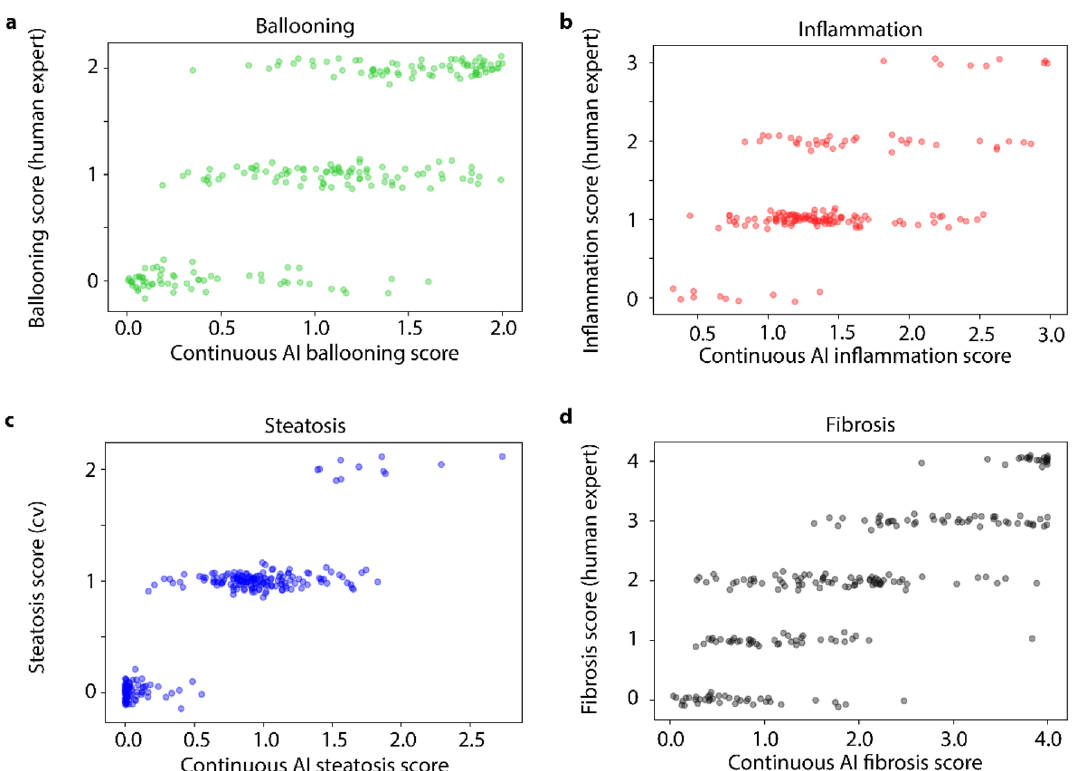
Figure 6. Continuous AI scores vs. discrete ground truth scores. Results for ( a ) Ballooning, ( b ) inflammation, ( c ) steatosis, and ( d ) fibrosis. AI scores on the horizontal axis are results from ANN fits on unseen validation data (four-fold cross validation). The AI scores cover the same range as the pathologist scores but are continuous. Jitter was added to the discrete pathologist scores for visualization purposes. The steatosis ground truth is a corrected score from a separate computer vision analysis of steatosis the slides, since pathologists systematically overestimate steatosis scores as shown in Fig S1. Our corrected scores were exclusively in the range